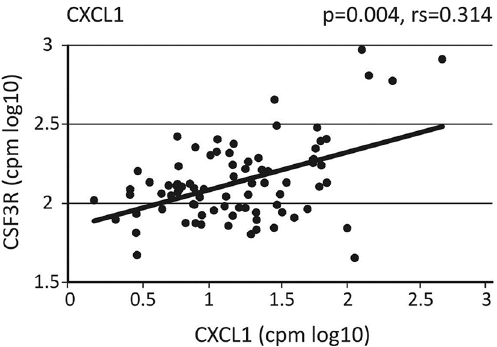
Figure 1. Association of the expression levels for neutrophil chemotactic CXCL1 with the neutrophil associated gene CSF3R. Shown are log transformed expression values in counts per million for CXCL1 and CSF3R in male A and E samples. p -values were determined using the Spearman’s rank correlation test.